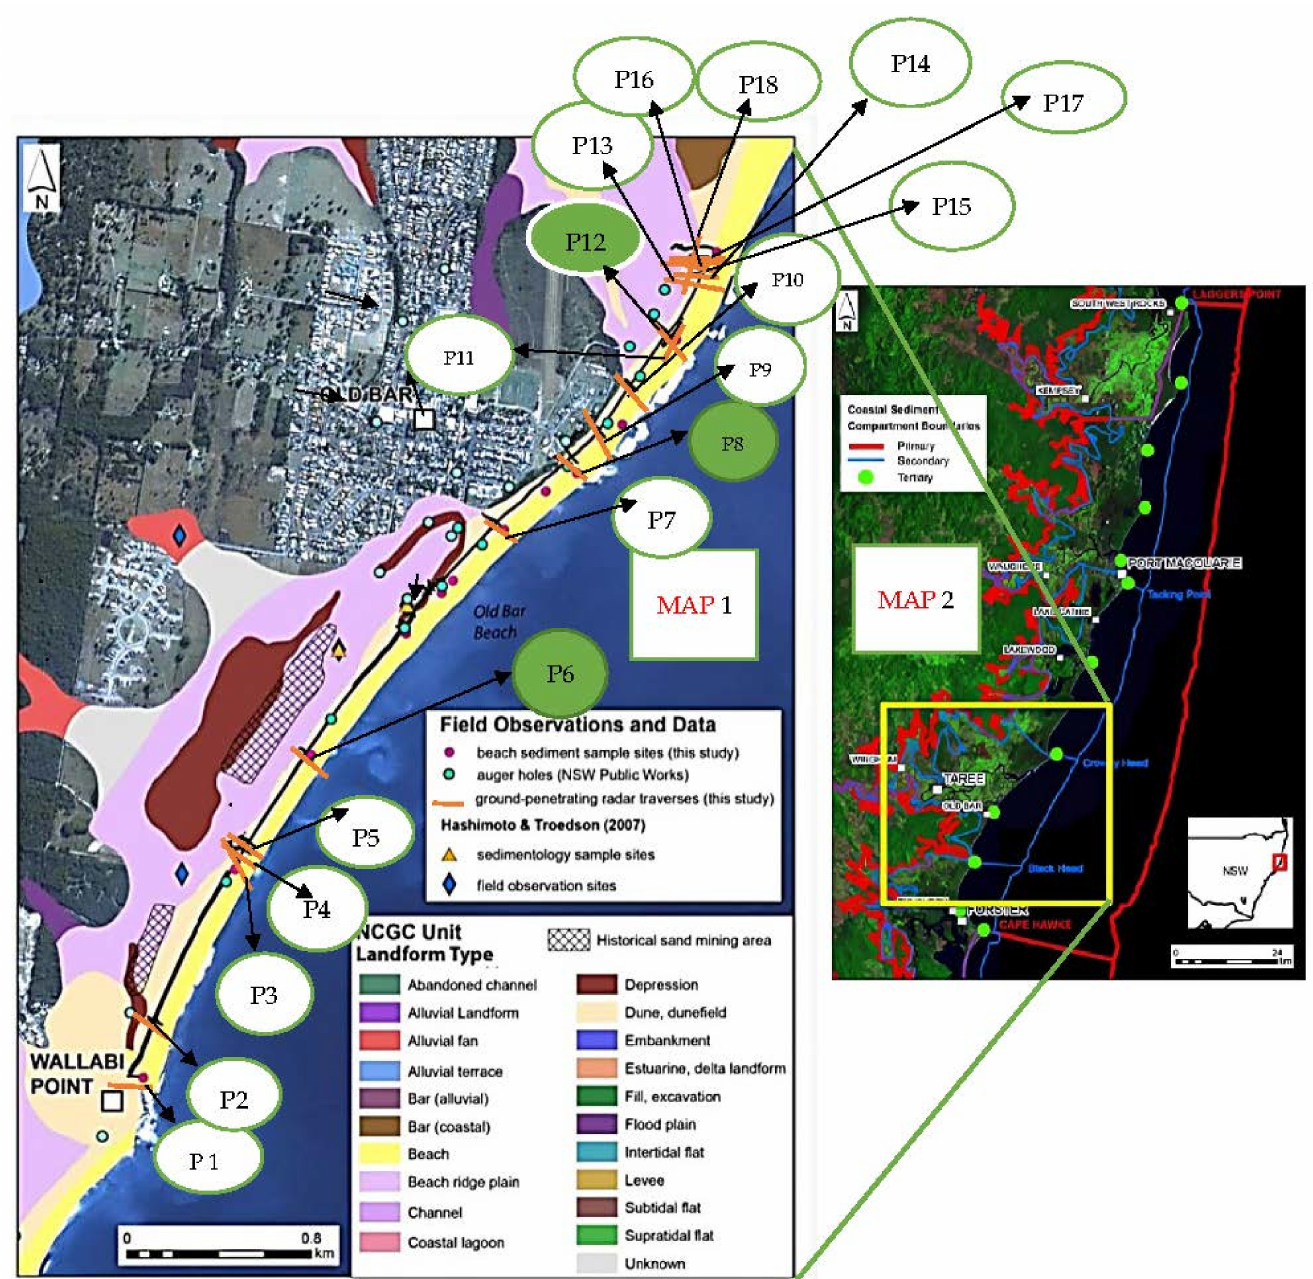
Figure 9. Coastal sediment compartment boundaries in MAP 2 and landform types in MAP 1 from Old Bar Beach, NSW, Australia. A GPR survey was carried out along 18 profiles (P) denoted by small saffron lines in MAP 1, which are perpendicular to the surface water line except for P11. Profiles (P) denoted by P6, P8, and P12 in green circles in MAP 1 were studied in our research. All GPR data were acquired within a geographical bounding box shown with a yellow rectangular box in MAP 2 with coordinates 152.54 ◦ , − 32.35 ◦ , 152.60 ◦ , and − 31.97 ◦ for west longitude, south latitude, east longitude, and north latitude, respectively